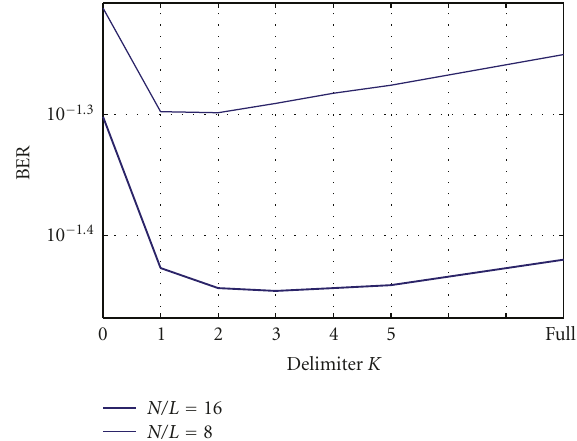
Figure 5: BER performance at SNR = 20 dB versus delimiter K . μ = 1, Q = 2, ω = 0 .